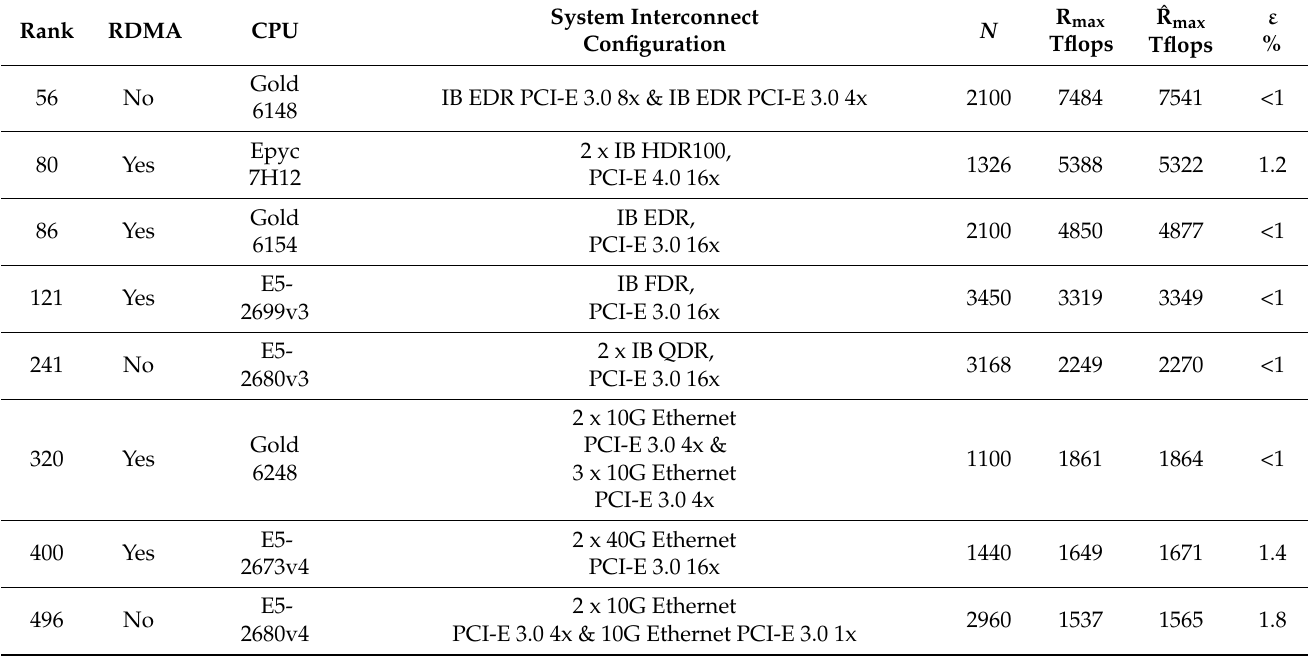
Table 1 contains the results of calculations for various clusters from June 2021 TOP500, which are not shown in Figures 3 and 4, specifically selecting clusters from different parts of the TOP500 table with processors of different generations and different system connections. Table 1. Results of calculations of ˆR max and ε according to the June 2021